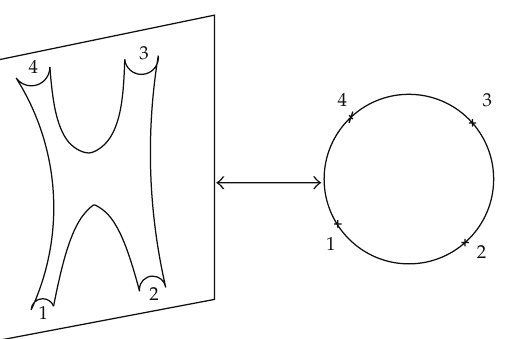
Figure 1: World-sheet corresponding to the scattering of four open strings. In the figure on the left we see four open strings ending on the IR D -brane; the world-sheet has then the topology of a disk, shown on the right, with four vertex operator